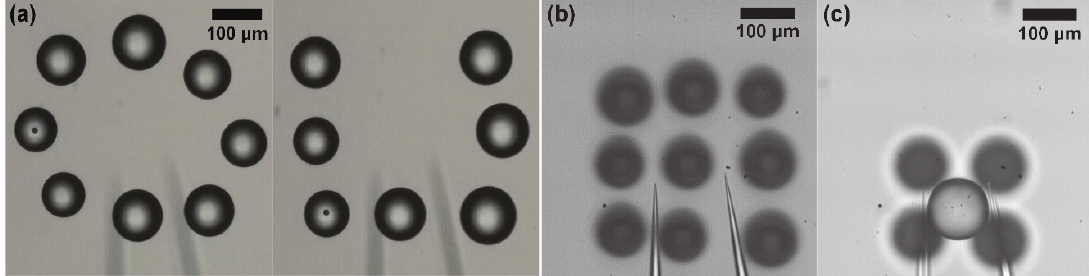
Figure 12. Results of the manipulation. ( a ) Several objects for making special characters (“O” and “U”); ( b ) Nine objects for making 2D structure; ( c ) Five objects for making 3D structure.